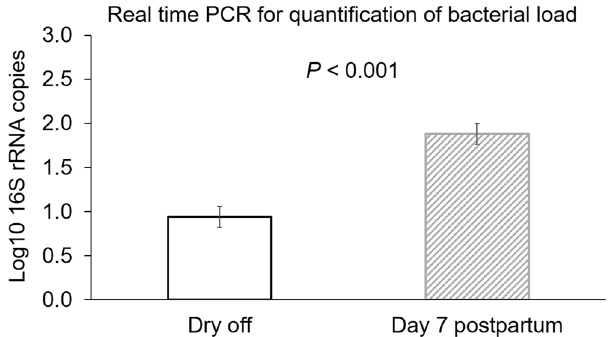
Figure 3. Bar graph illustrating the mean log10 number of the 16S rRNA gene identified in milk samples collected at dry off and 7 days postpartum. Error bars correspond to standard error of the mean.